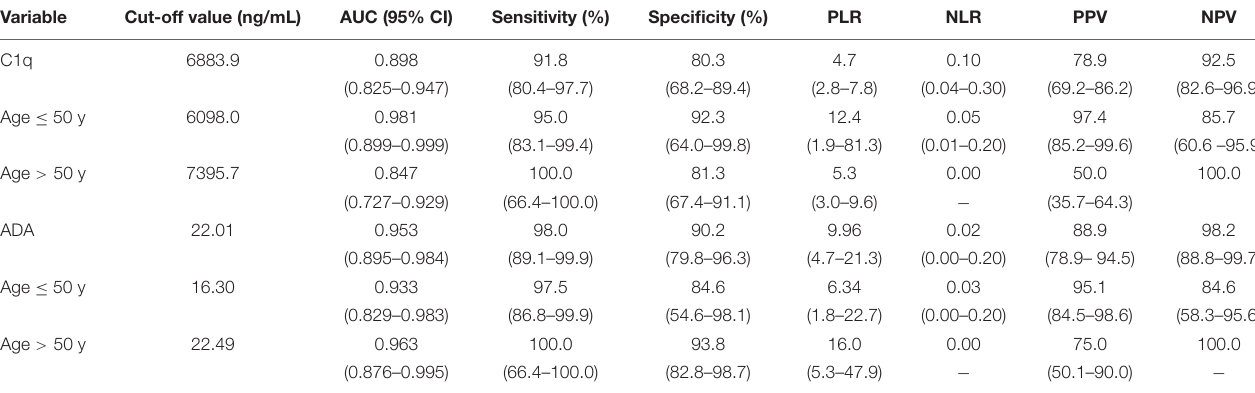
TABLE 3 | Diagnostic performance of C1q and ADA in PF in differentiating between patients with TPE and those with non-TPE according to age. Variable Cut-off value